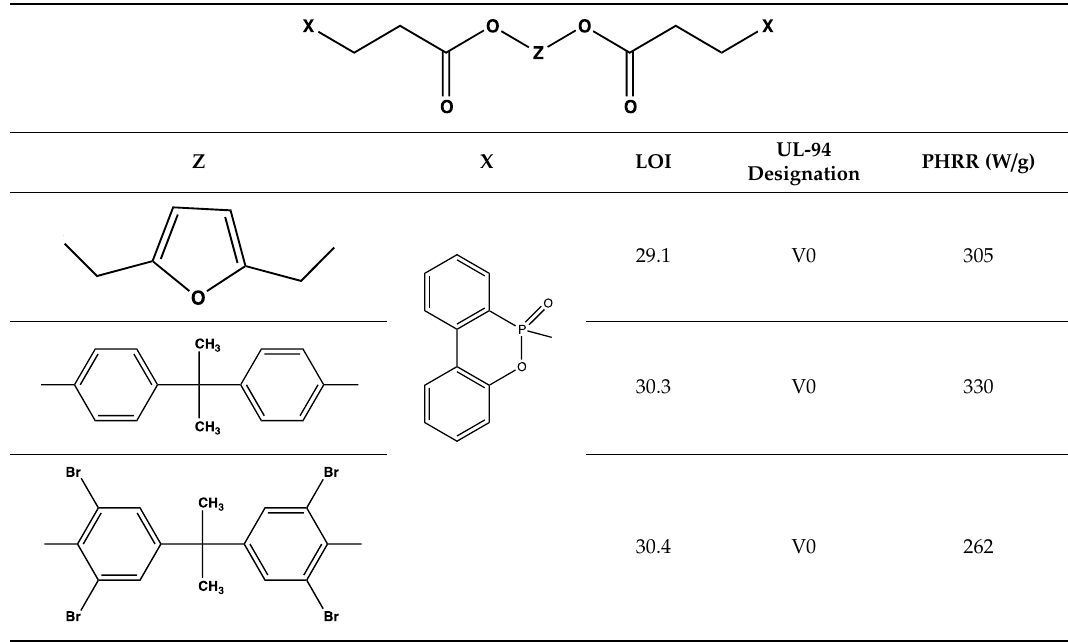
Table 5. Flammability of blends (2% Phosphorus) of the 9,10-Dihydro-9-oxaphosphaphenanthrene- 10-oxide (DOPO) adducts of 2,5- bis (Hydroxymethyl)furan diacrylate, bisphenol A Diacrylate, and tetrabromobisphenol A diacrylate with DGEBA epoxy.